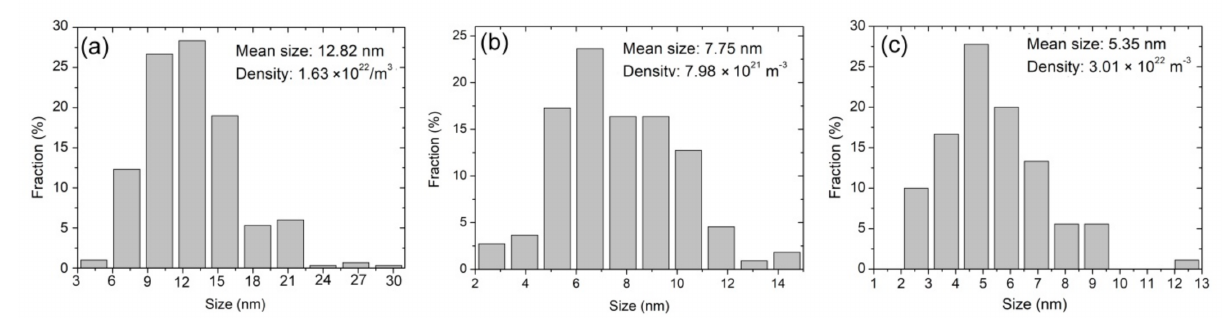
Figure 5. ( a ) Dislocation loop size and ( b ) cavity–diameter distributions in the Fe and He co-irradiated SIMP steel to fluences of 1.65 × 10 16 Fe 3+ · cm − 2 and 4.5 × 10 15 He + · cm − 2 , ( c ) dislocation loop size distribution in the He implantation with Fe pre-irradiation into SIMP steel to fluences of 1 × 10 16 Fe 10+ · cm − 2 and 5 × 10 14 He + · cm − 2 . It shows a skewed distribution in ( a – c ).